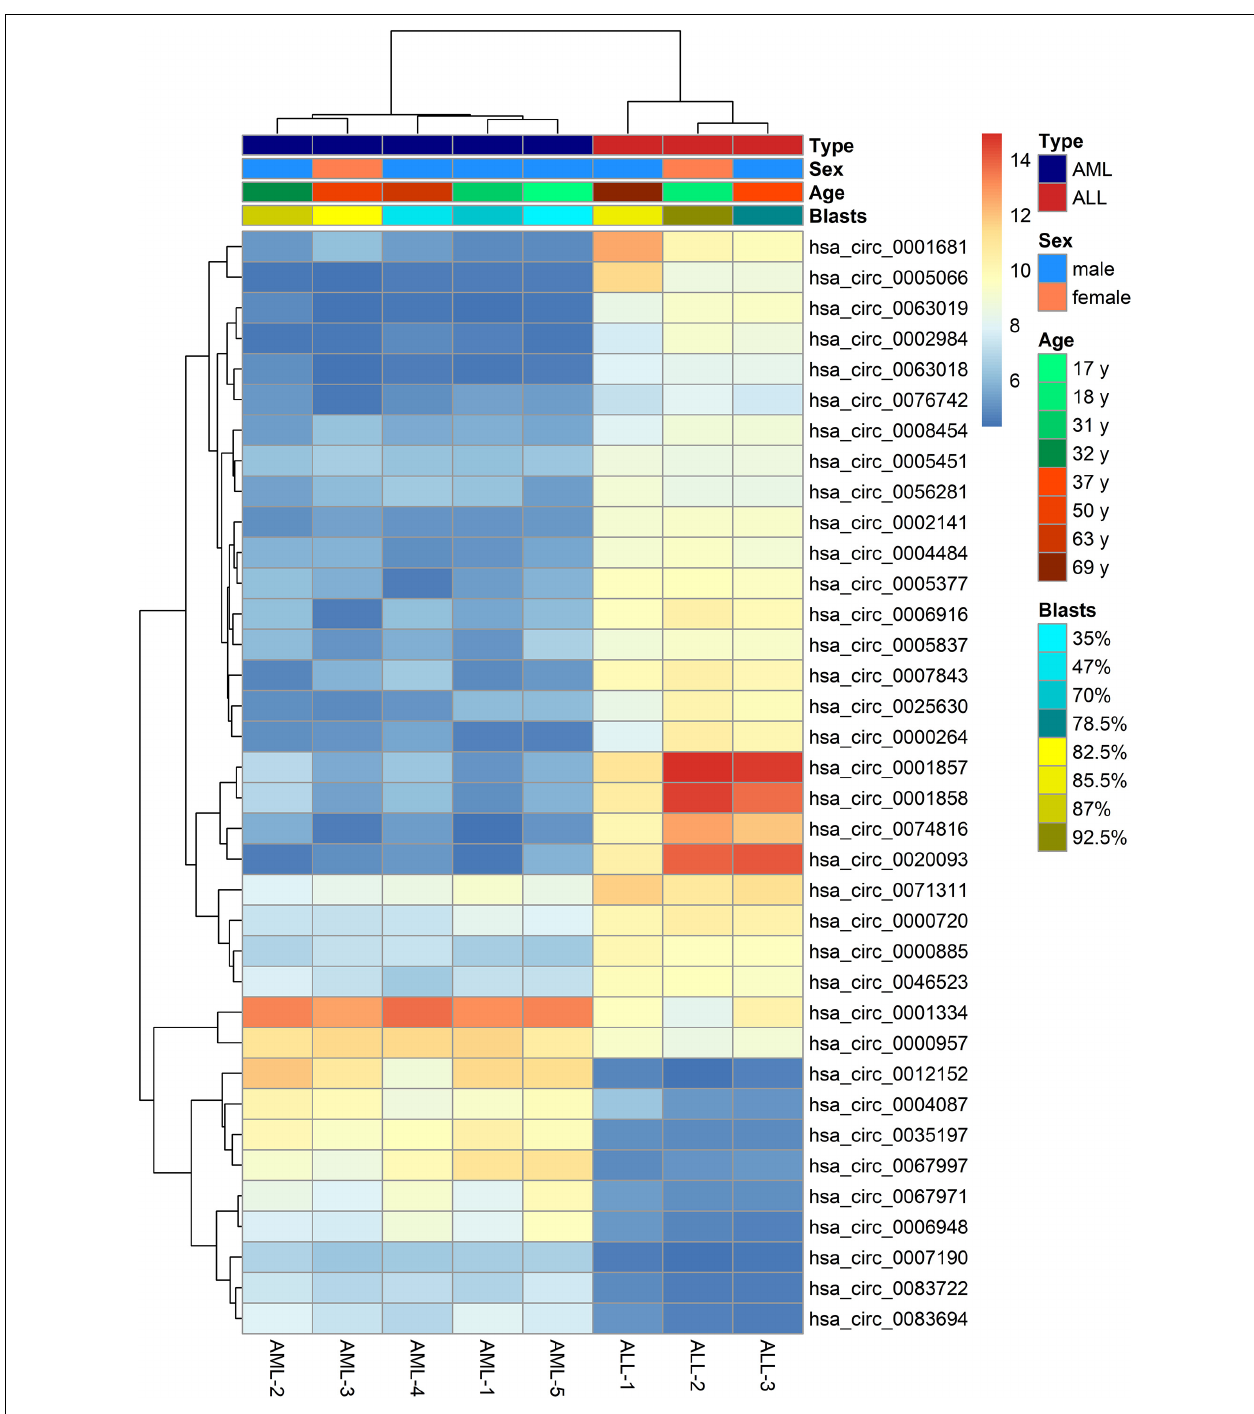
FIGURE 1 | Heatmap of differentially expressed circular RNAs (circRNAs) between acute lymphoblastic leukemia (ALL) and acute myeloid leukemia (AML). The horizontal axis shows the samples, and the vertical axis shows differentially expressed circRNAs. That is, there is one circRNA for each line, and one sample for each column. Red and gray indicate upregulated and downregulated expression, respectively, in ALL compared with AML; the darker the color, the greater the difference.